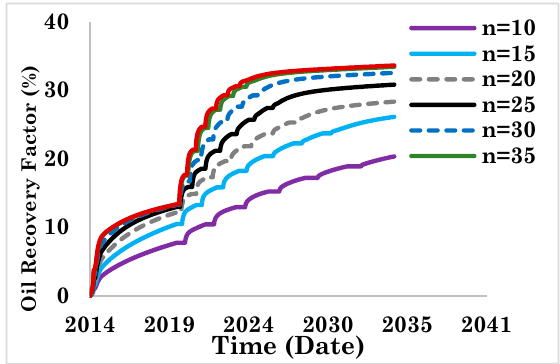
Figure 11. C 2 H 6 Injection (Extended Cycle Size) 38 API Oil.